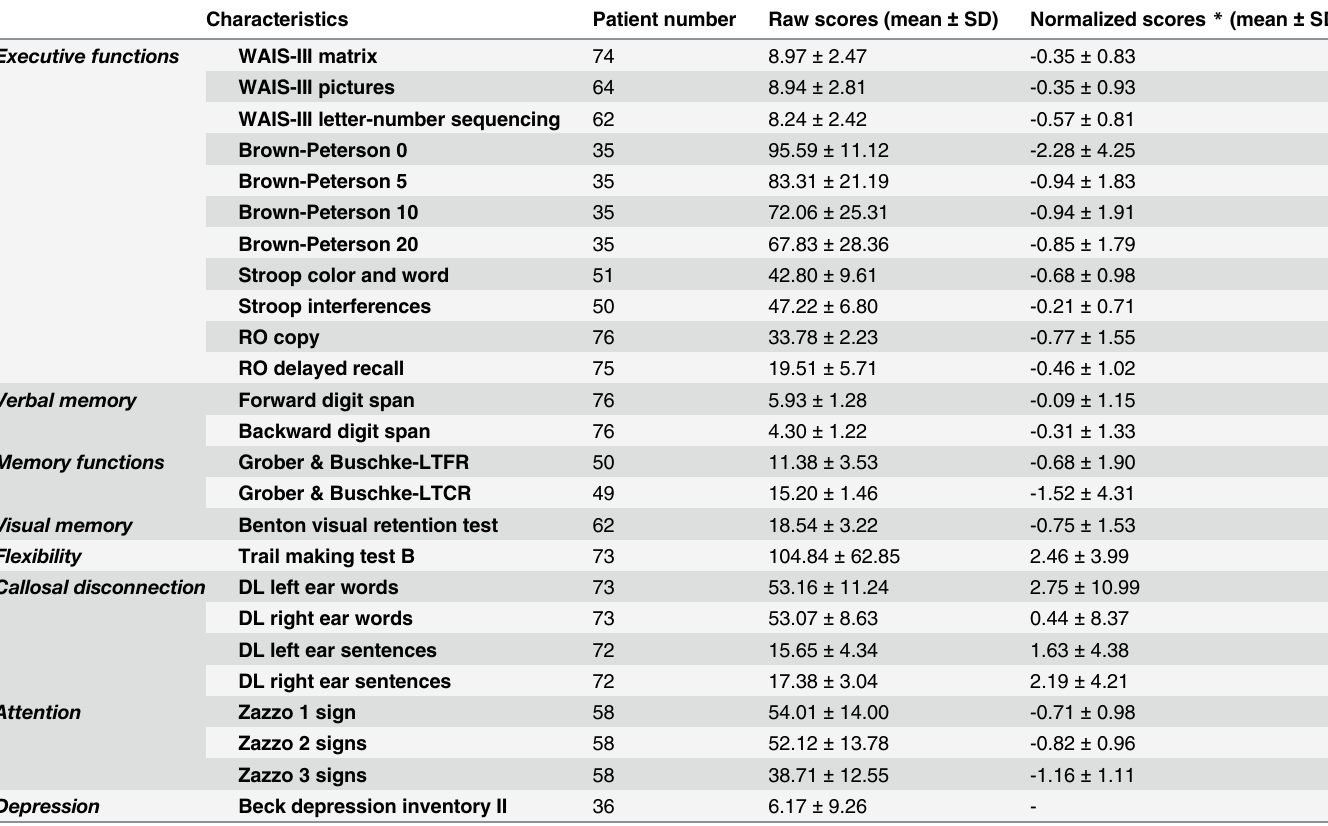
Table 1. Patient performance to neuropsychological tests.